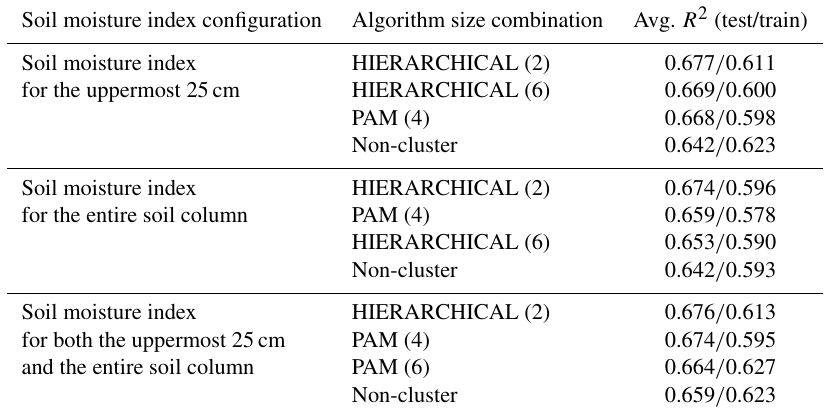
Table 2. Table with the average R 2 for the test and training samples for the three best combinations of cluster algorithm and cluster size (in parentheses) for three soil moisture